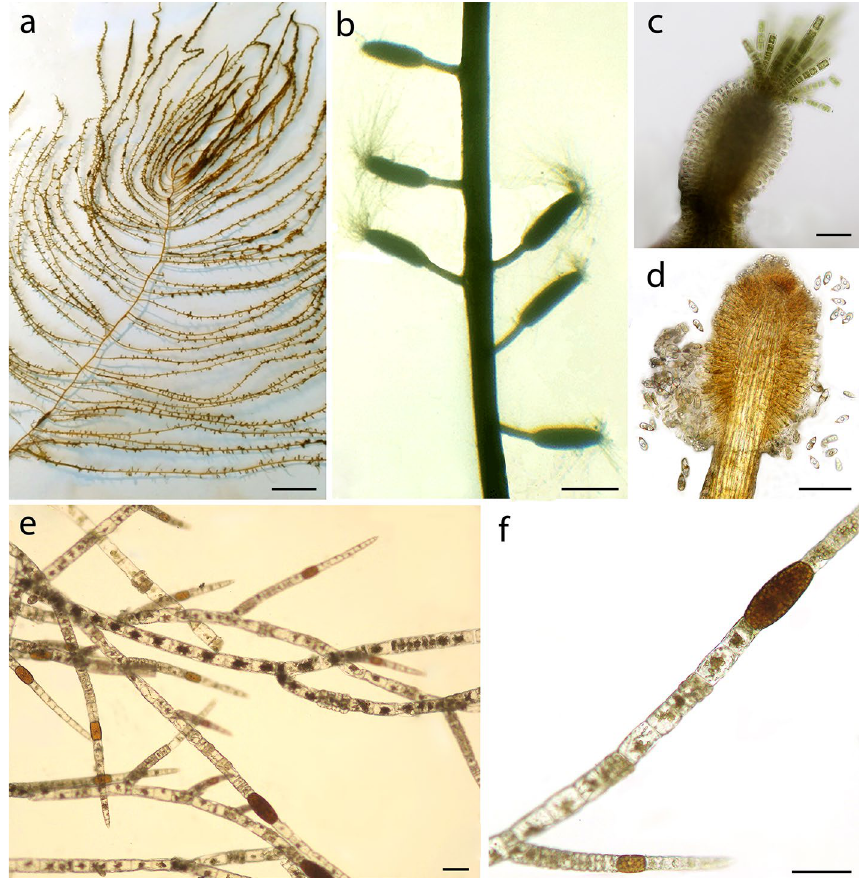
Figure 5. Details of the two most common macroalgae found on gorgonians. Sporochnus pedunculatus : ( a ) Habit; ( b ) Portion of thallus showing stalked receptacles; ( c ) Receptacle with a terminal tuft of assimilatory filaments; ( d ) Zoospores released from mature sporangia. Pylaiella littoralis : ( e ) Branching pattern; ( f ) Fertile filament showing intercalary plurilocular sporangia. Scale bars: ( a ) 5 cm; ( b ) 1 mm; ( c – f ) 100